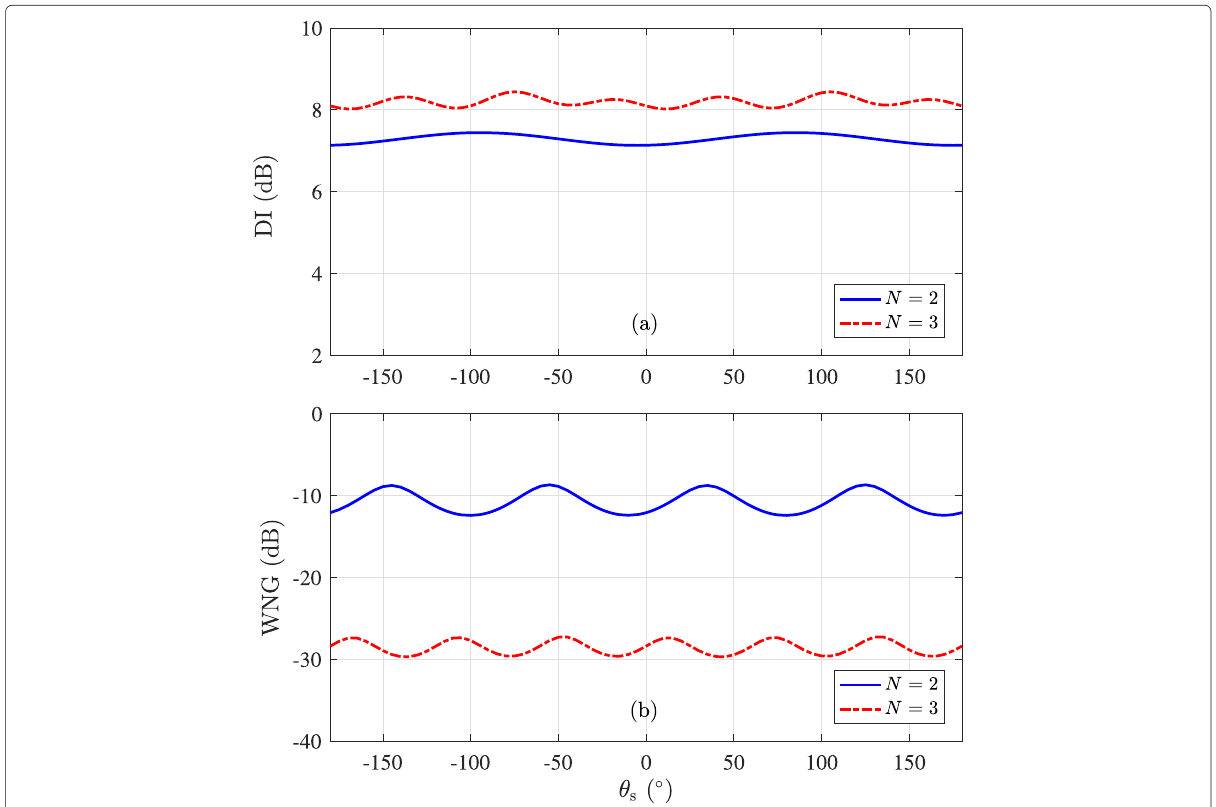
Fig. 10 DI and WNG of the robust differential beamformer for different look directions: a DI and b WNG